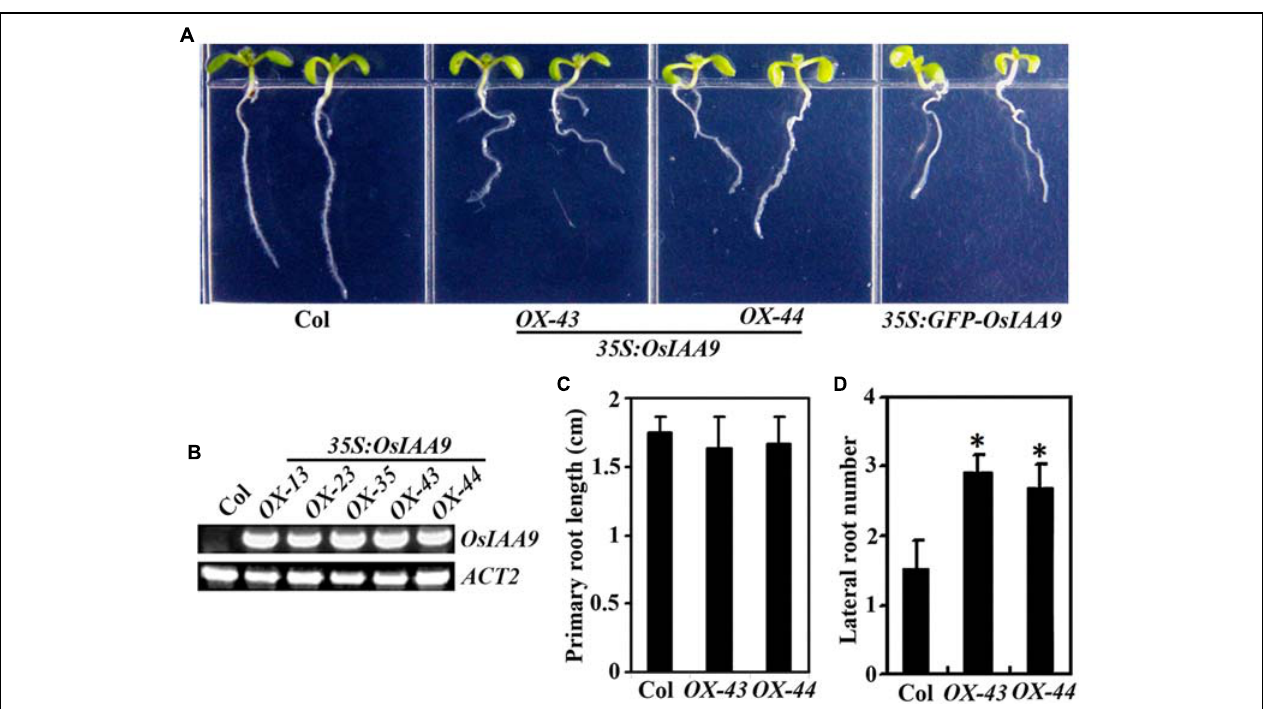
FIGURE 5 | Morphologies of Arabidopsis transgenic plant seedlings expressing OsIAA9 . (A) Seven-day-old Col wild type and transgenic plant seedlings. (B) Expression of OsIAA9 in transgenic plants. RNA was isolated from OsIAA9 transgenic Arabidopsis seedlings and RT-PCR was used to examine the expression of OsIAA9 . Expression of ACT2 was used as a control. (C) Primary root length of 7-day-old wild type and transgenic plants. (D) Lateral root number of 10-day-old wild type and transgenic plants. Data in (C) and (D) represent the mean ± SD of 12–15 seedlings. ∗ , significantly different from Col wild type seedlings ( p < 0.0001).